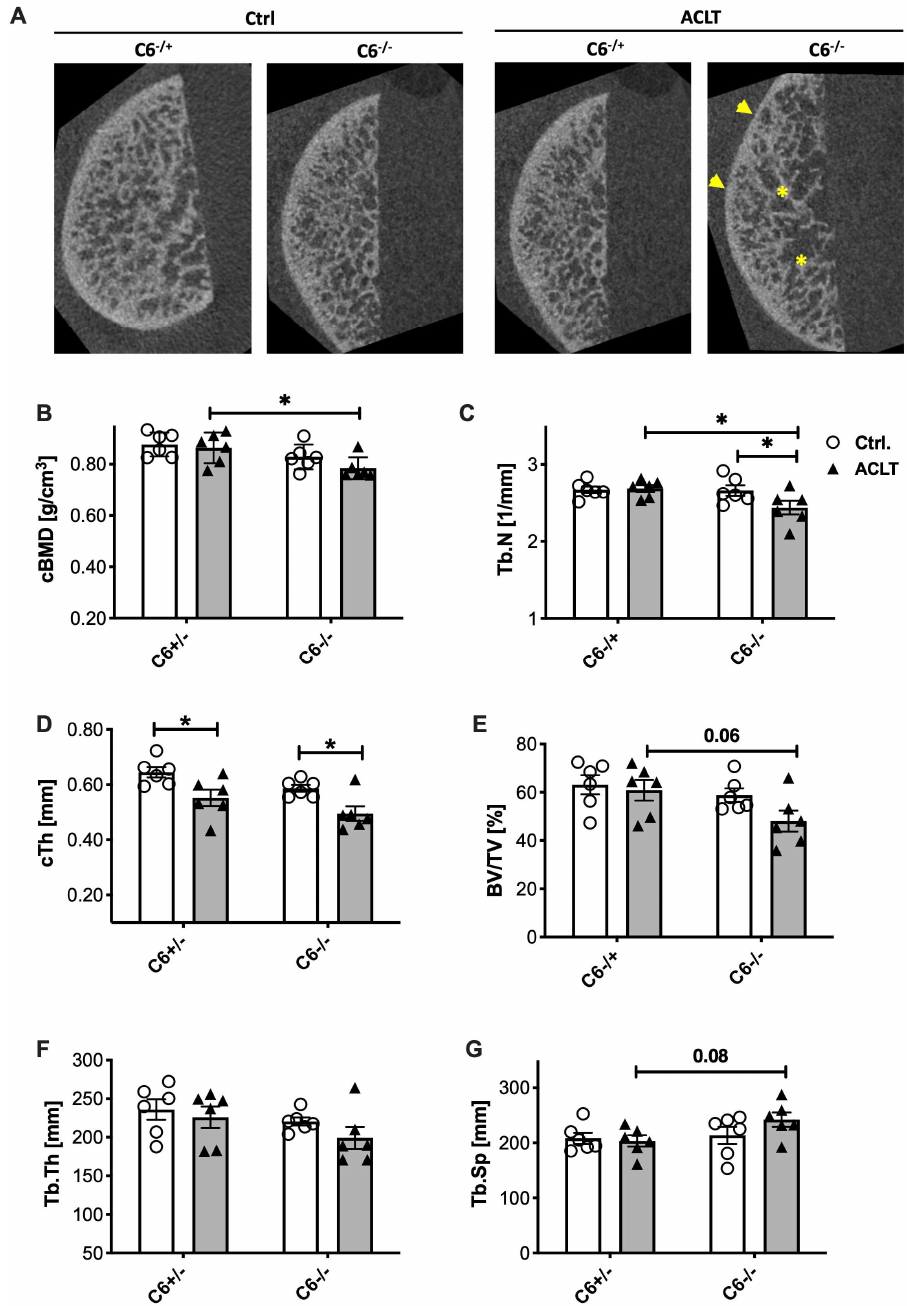
Figure 6. Structural analysis of subchondral bone. ( A ) Exemplary image of µ CT analysis after 8 weeks; reduction in cortical thickness is indicated by yellow arrowheads, reduction in BV/TV and Tb.N., respectively, is indicated by yellow asterisks. Statistical analysis of ( B ) cBMD, ( C ) Tb.N, ( D ) cTh, ( E ) BV/TV, ( F ) Tb.Th, and ( G ) Tb.Sp. Data are displayed as scattered bars with mean and SEM; white bars= control joint, grey bars= ACLT-operated joints. Statistically significant differences between groups ( n = 6 each) were depicted as: *: p ≤ 0.05.